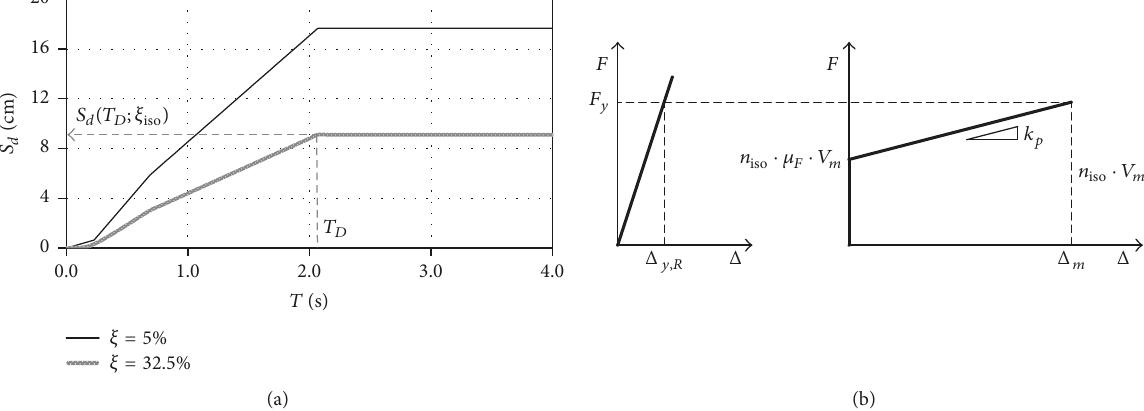
Figure 10: (a) Design displacement spectra; (b) force-displacement diagram of the pier column and of the FPD isolator .